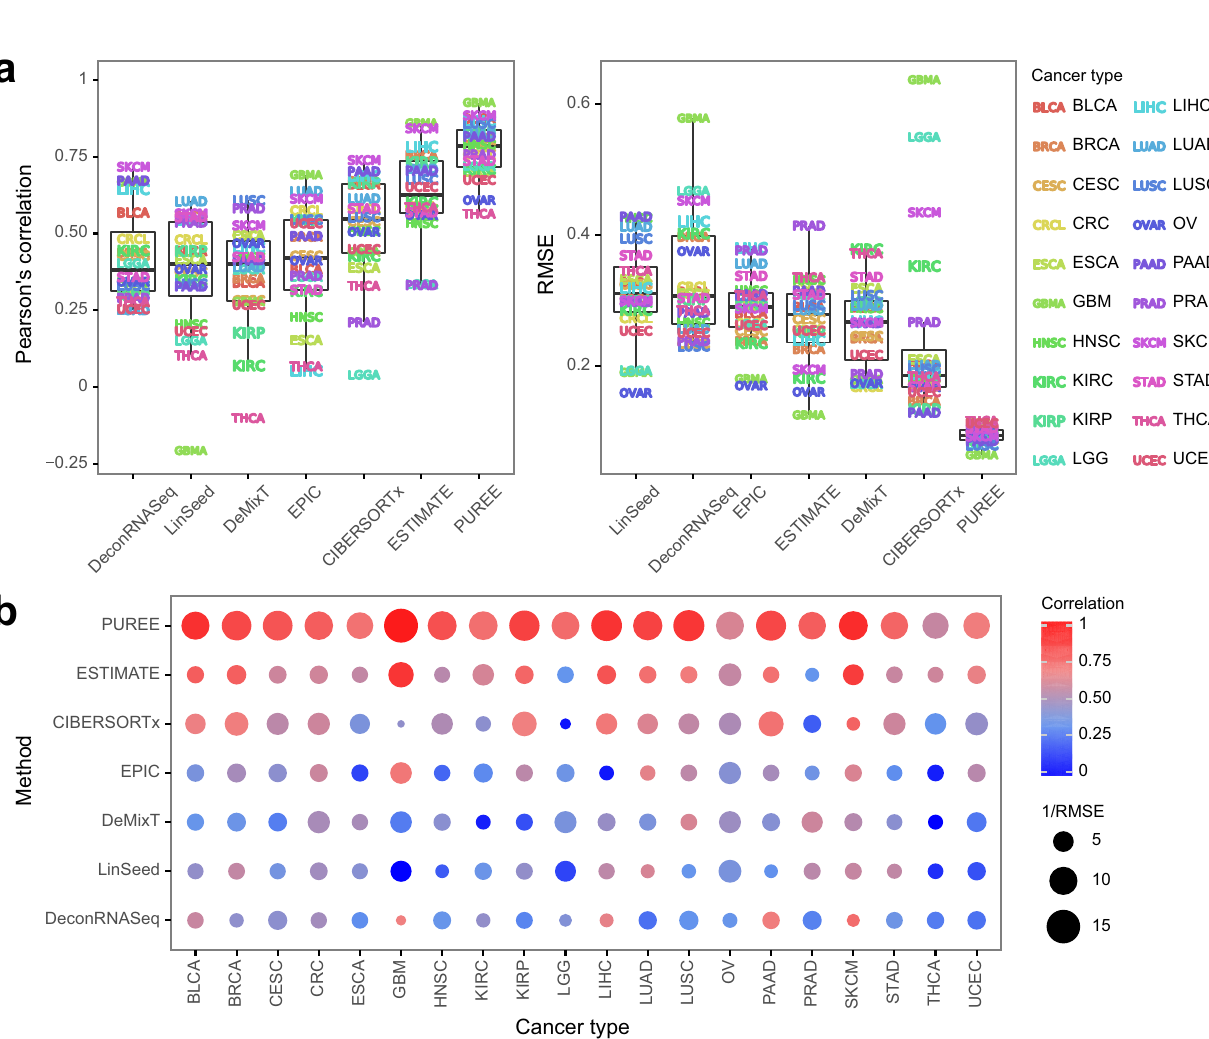
Fig. 4 Comparing PUREE and existing methods on TCGA data. Comparison of PUREE and 6 existing transcriptome deconvolution methods. a Mean Pearson ’ s correlation and RMSE of methods per cancer type when compared with genomic tumor purity estimates on the TCGA test data split (1573 samples). b Aggregated mean correlation and RMSE metrics per cancer type for each method. In the boxplots in ( a ), the lower and upper hinges correspond to the fi rst and third quartiles, the upper whisker extends to the largest value no further than 1.5 of inter-quartile range from the hinge, the lower whisker extends to the smallest value no further than 1.5 of inter-quartile range from the hinge, and points beyond the end of the whiskers are plotted